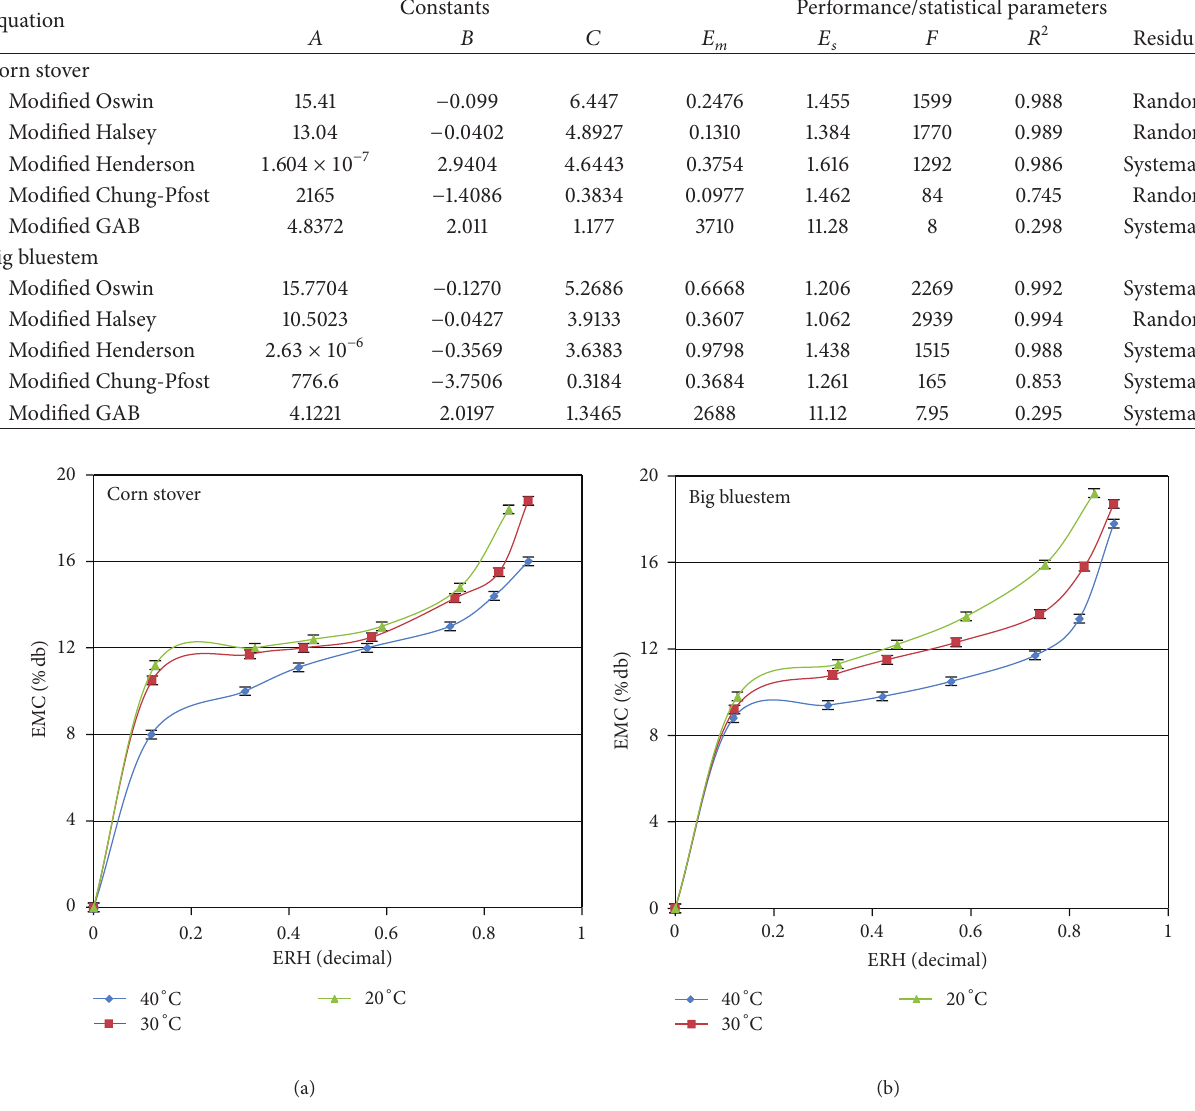
Table 4: Fitted isotherm parameters for corn stover and big bluestem.